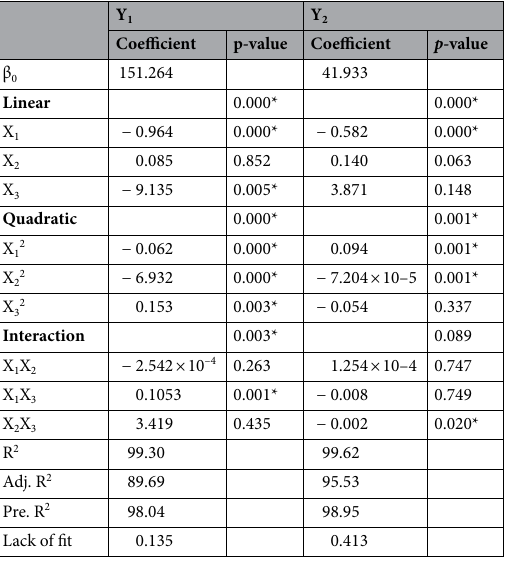
Table 3. Analysis of variance of the predicted models for quercitrin and TPC from C. caudatus leaves. Parameter values with * is significant term at p ≤